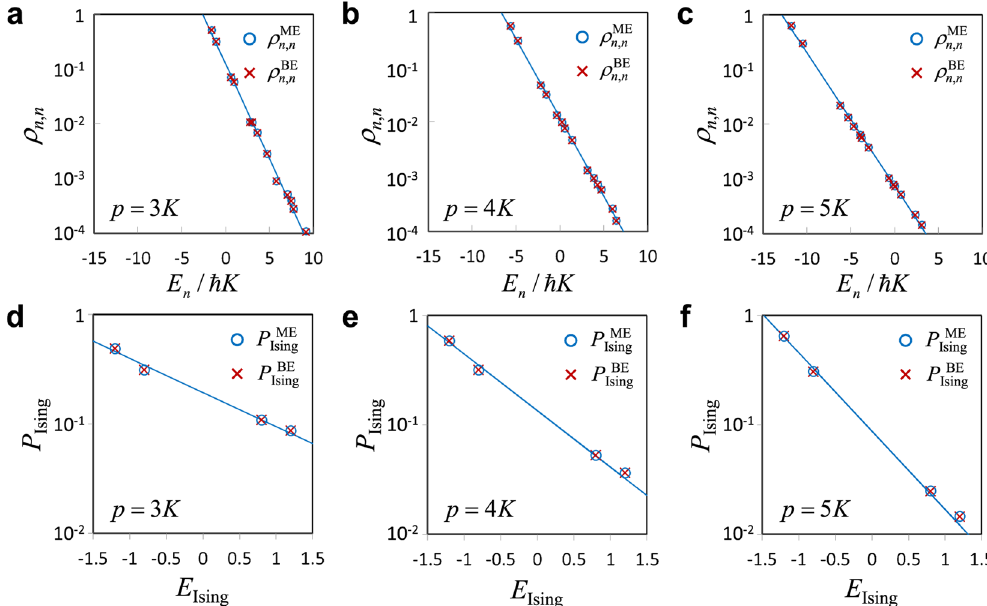
Figure 5. Quantum heating of dissipative QbM. The parameters of the two-spin Ising model are the same as that in Figs 1 and 2. ( a – c ) Probability distributions of the quasienergies E ,BE (crosses) correspond to the steady-state solutions of the master equation [Eq. (8)] with κ = . K 0 05 and the ρ n n balance equation [Eq. (13)], respectively. The lines show exponential fits to { } distributions of the spin configurations. s P ( ) IsingME (circles) and s P ( ) IsingBE (crosses) correspond to the steady-state solutions of the master equation with κ = . K 0 05 and the balance equation, respectively. The lines show the Boltzmann distribution fitting to s P ( ) IsingME